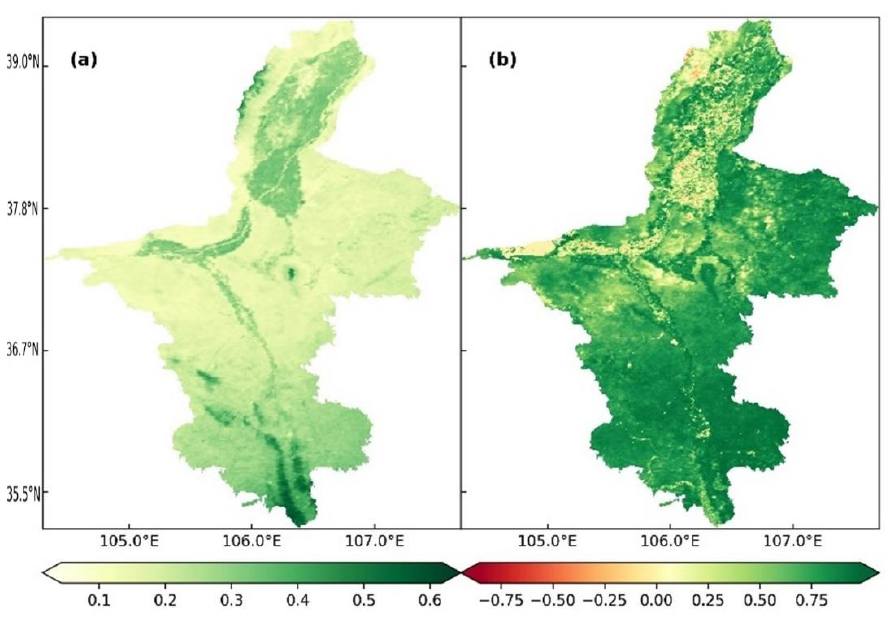
Figure 7. ( a ) Spatial distribution of the average NDVI in Ningxia from 2001 to 2020. ( b ) Spatial distribution of correlation between ET and NDVI in Ningxia from 2001 to 2020.